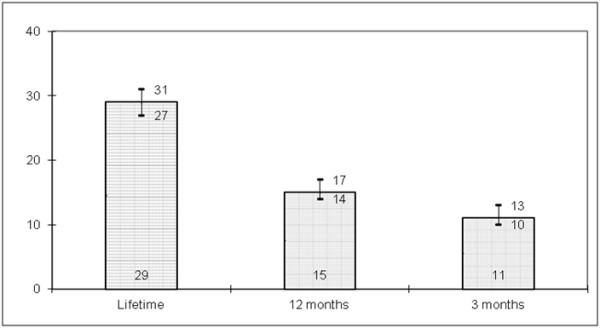
Percentage of men reporting non-marital sexual behaviour, over three time periods (with 95% CI).